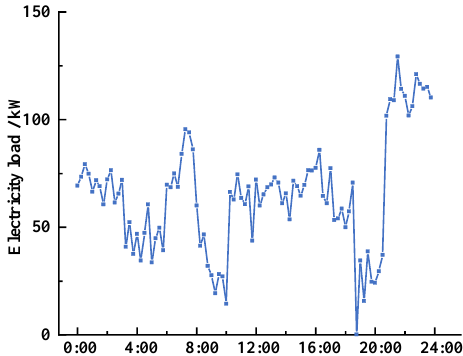
Figure 7. Load curve of the air conditioning in a heating